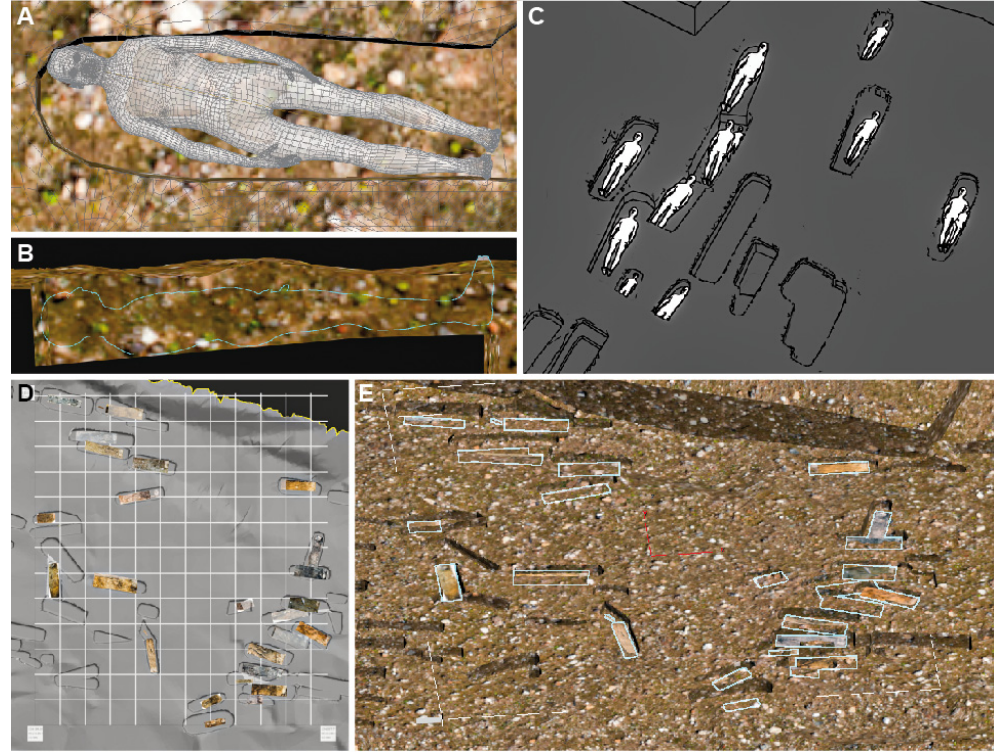
Figure 4. ( A , B ) A dummy’s head-to-head positioning process in burial 114 to position the bottom more precisely; ( C ) Stylized 3D view of the same process in progress on burials 104, 105, 110, 114, 115, 122, 123, 125, 126, 136, 170 and 174; ( D , E ) Integrating photos taken on-site with Virtualanthropy software.